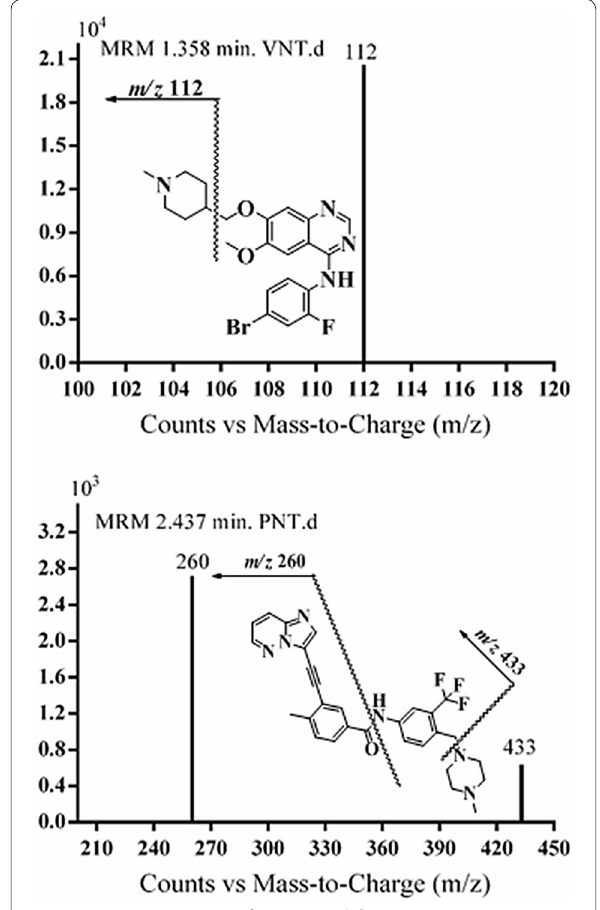
Fig. 2 MRM mass spectra of ( a ) VNT and ( b ) IS